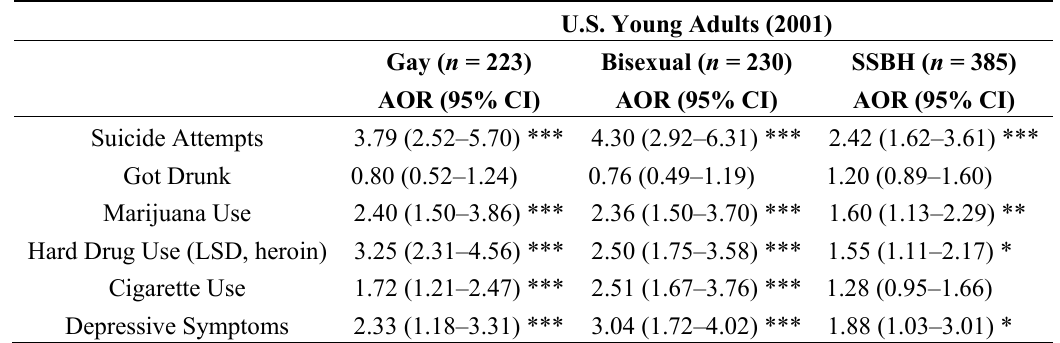
Table 3. Odds of mental health and substance use outcomes among sexual minorities compared to heterosexuals (2001) in the